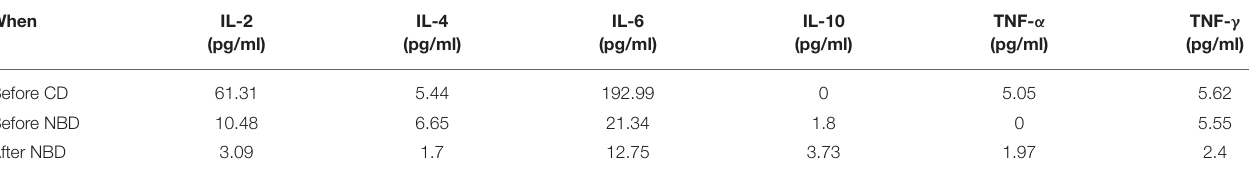
TABLE 1 | Counts of Th1 and Th2 subsets of helper T